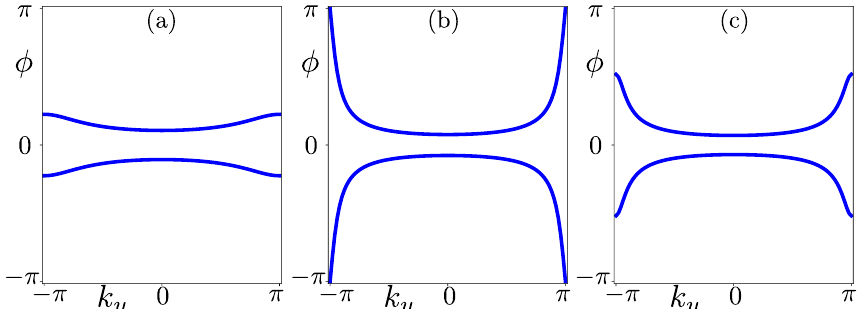
) of the 2 × 2 matrix r is calculated across the Figure 5: The dispersion φ ( k y phase transition related to the y -edge gap closing of the 2D system. In all panels λ = λ = 1, and there are 36 sites in the x direction. In panel (a), the 2D system x y = γ = 0.4. The intracell hoppings for panel (b) are is in a HOTI phase with γ x y γ = 0.4 and γ = 1, and in panel (c) γ = 0.4 and γ = 1.2. The band gap closing x y x y at φ = π signals the disappearance of π -modes in the φ -spectrum corresponding to the reflection matrix of a finite 2D